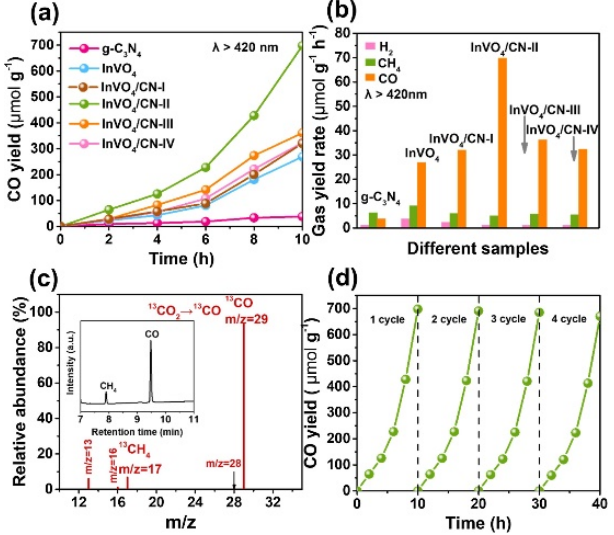
Figure 20. ( a ) CO generation and ( b ) average gas evolution rates of H 2 , CH 4 , and CO in MeCN/H 2 O system over various photocatalysts for 10 h photocatalytic reaction under visible light irradiation (with a UVCUT − 420 nm filter). ( c ) Mass spectrum of 13CO (m/z = 29) produced over InVO 4 /CN-II in the photoreduction of 13CO 2 . ( d ) Cycling production of CO over InVO 4 /CN − II under visible light irradiation [173]. The production of H 2 as an energy source has been studied increasingly in the last few years. Hamdy et al. [168] propose a novel polyaniline/ZnO heterojunction, synthesized via sol-gel/polymerization route for photocatalytic hydrogen production under a visible light source. The amount of polymer has a fundamental role in photocatalytic activity as it plays a uniform deposition of it on the ZnO surface (Figure